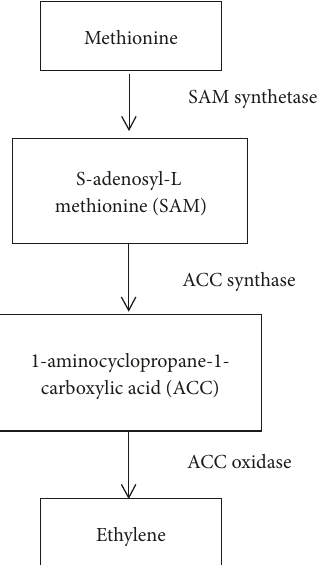
Figure 2: The mechanism of ethylene biosynthesis from methion-